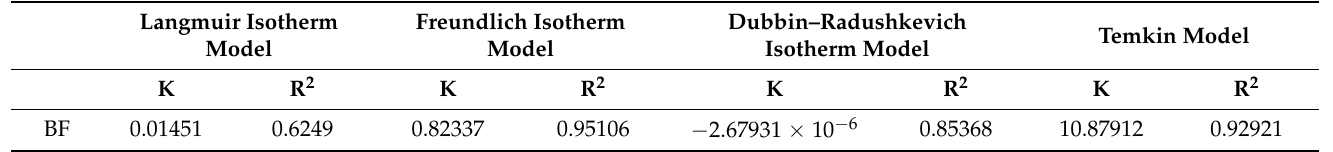
Table 3. The isotherm parameters for the adsorption of BF dyes. Langmuir